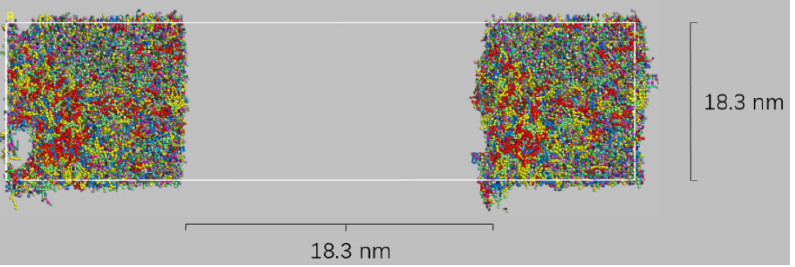
Figure 5. Bitumen microcrack model.